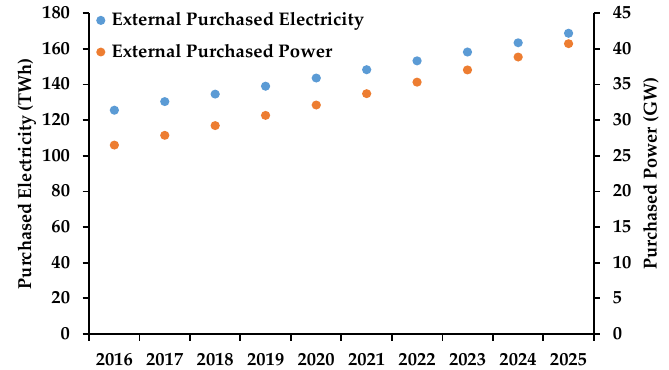
Figure 4. External purchased electricity and power in the planning horizon.